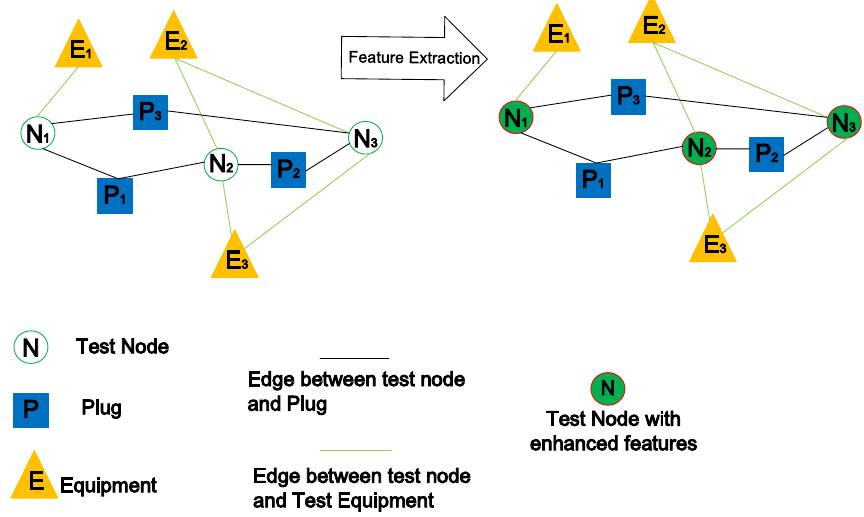
Fig. 5 Feature enhancement of key